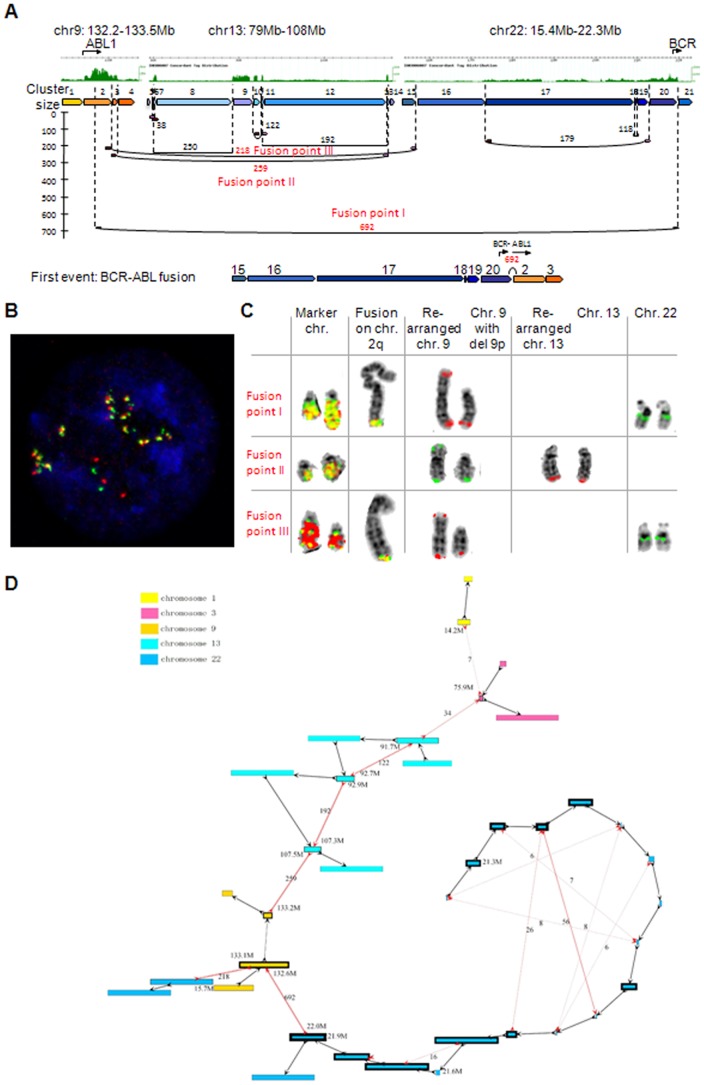
Reconstruction of the BCR-ABL1 amplicon of K562.(A) Concordant tag distributions representing copy number are shown for amplified genomic regions (top, green track). Genomic segments between predicted breakpoints are indicated by colored arrows and dPET clusters with cluster sizes greater than 35 of predicted somatic rearrangements are represented by horizontal lines flanked by dark red and pink arrows indicating 5′ and 3′ anchor regions (middle). Small to large dPET clusters are arranged from top to bottom. Cluster sizes are indicated. High dPET cluster size of the CML causing BCR-ABL1 translocation suggests that the rearrangement occurred early and that it has subsequently been amplified. Fusion points I–III correspond to panels C–D. (B) Fluorescence in situ hybridization (FISH) of BCR-ABL1 rearrangement (fusion point I with cluster size 692). Yellow spots represent fusion signals and illustrate the amplification of BCR-ABL1. (C) FISH analysis of metaphase chromosomes of three high copy fusion points: I) probes used in B show fusion signals on two marker chromosomes and on chromosome 2q and normal localization on both rearranged chromosomes 9 and normal chromosome 22; the fusion on chromosome 2 has not been identified by DNA-PET most likely due to low sequence complexity at the break point or complex rearrangements, II) probes spanning the fusion point II (cluster size 259) show fusion signals on the same marker chromosomes and normal localization on both normal and rearranged chromosomes 9 and 13, III) probes spanning fusion point III (cluster size 218) show fusion signals on the same marker chromosomes and normal localization on both normal chromosome 22 and rearranged chromosomes 9. (D) Contigs (indicated by boxes) which were covered by PET mapping were concatenated by fusion-point-guided-concatenation method. The length of a contig is represented by the length of the box. Because of the size difference between chromosomes 1, 3, 9, 13, and 22, the length of chromosome 22 is represented by the length of contig/10,000 while the lengths of chromosomes 1, 3, 9, and 13 are represented by the length of contig/100,000. Any value less than 0.1 is rounded to 0.1; any value larger than 6 is rounded to 6. The thickness of borders of each contig represents the coverage (copy number). Red dashed edges represent dPET edges, while black bold edges represent cPET edges. The thickness of dPET edges represents the size of the corresponding dPET cluster. cPET edges have uniform thickness. Arrow heads pointing towards a contig indicate connections with the lower coordinates, arrow heads pointing away from a contig indicate connections with the higher coordinates.